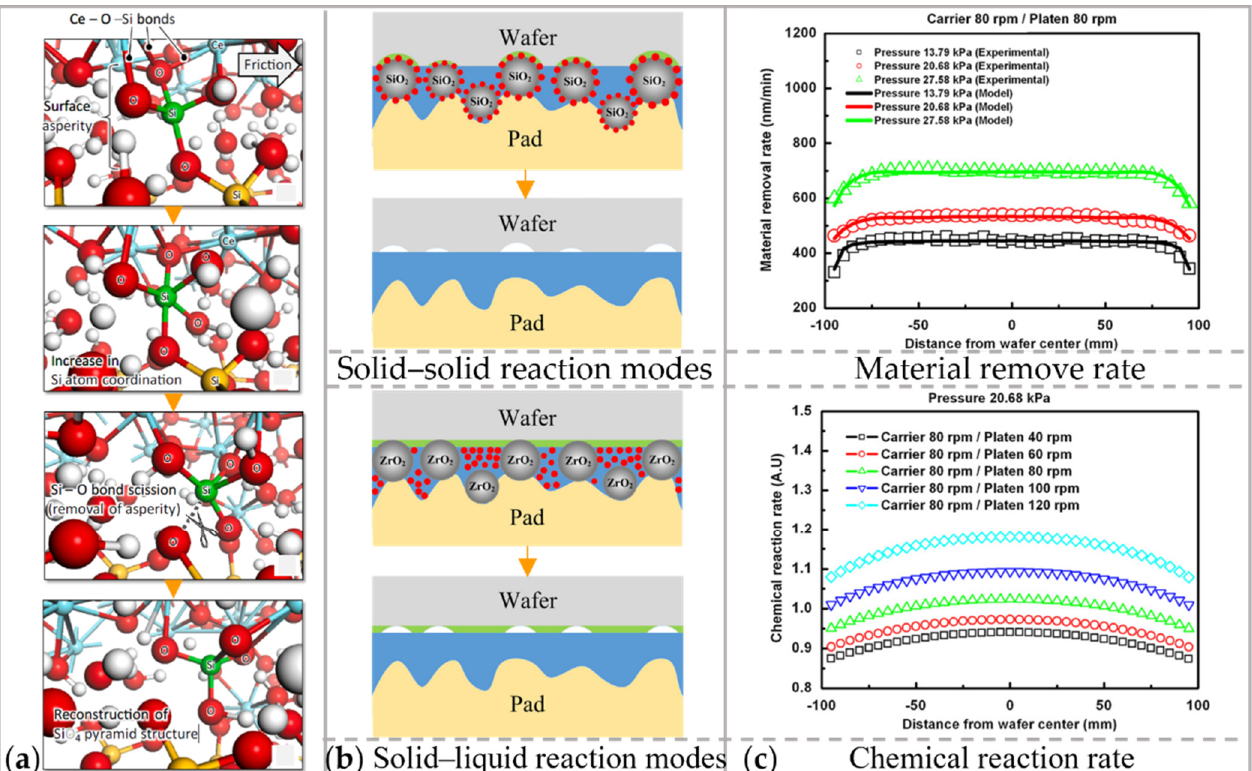
Figure 5. The removal mechanism in CMP from ( a ) Chemical reaction analyzed by first principles molecular dynamics. Reproduced with permission from [60]; ( b ) Chemical reaction divided into solid–solid reaction and solid–liquid reaction. Reproduced with permission from [61]; ( c ) Mechanical interaction. Reproduced with permission from [65].